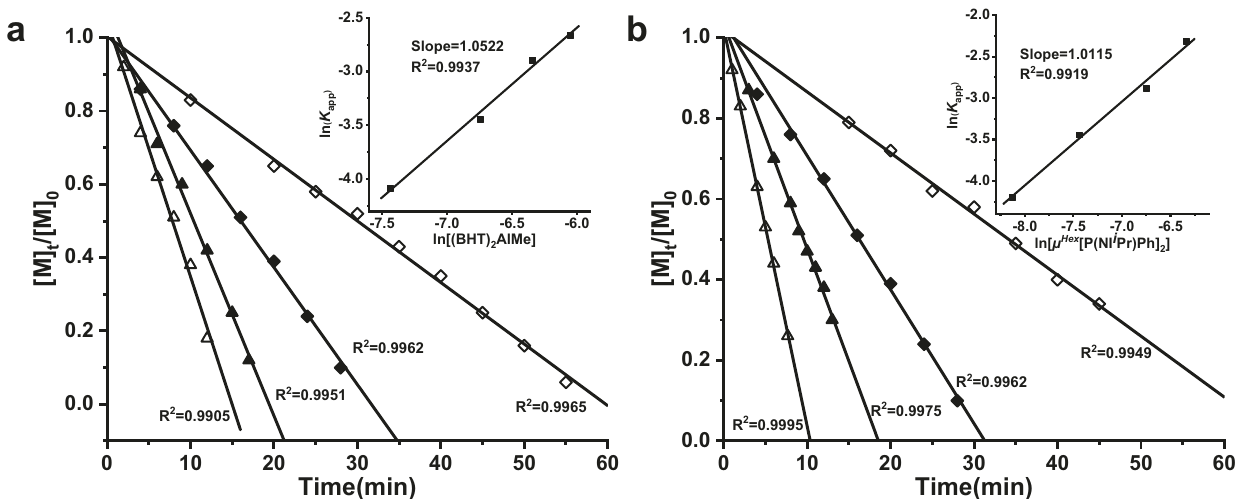
Fig. 5 Kinetic studies. a Zero-order kinetic plots for polymerization of MMA by (BHT) 2 AlMe/ µ Hex [P(NI i Pr)Ph] 2 in toluene at RT: [MMA] 0 = 0.936 M; [ µ Hex [P(NI i Pr)Ph] 2 ] 0 = 0.588mM; [(BHT) 2 AlMe] 0 = 1.764 mM ( ◇ ), 2.352mM ( ◆ ), 2.94 mM ( ▲ ), 3.528 mM ( Δ ). Inset: plot of ln( k app ) vs ln [(BHT) 2 AlMe]. b Zero-order kinetic plots for polymerization of MMA by (BHT) 2 AlMe/ µ Hex [P(NI i Pr)Ph] 2 in toluene at RT: [MMA] 0 = 0.936 M; [(BHT) 2 AlMe] 0 = 1.175 mM; [ µ Hex [P(NI i Pr)Ph] 2 ] 0 = 0.294 mM ( ◇ ), 0.588 mM ( ◆ ), 1.175 mM ( ▲ ), 1.764 mM ( Δ ). Inset: plot of ln( k app ) vs ln [ µ Hex [P (NI i Pr)Ph] 2 ].